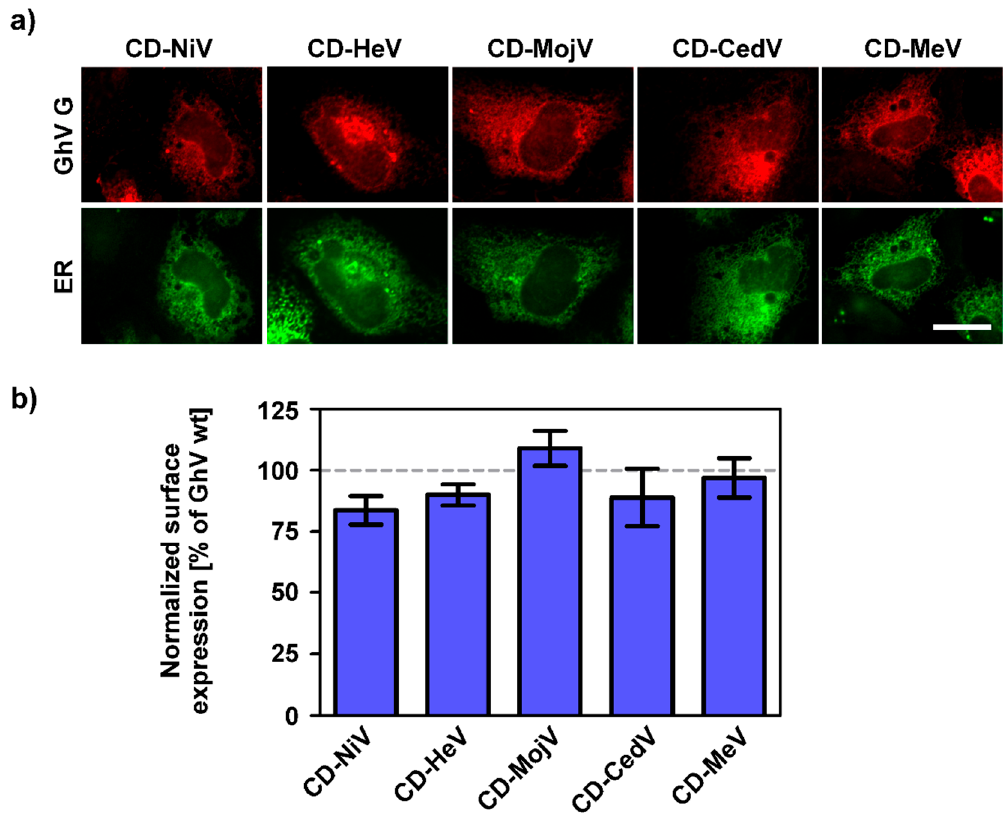
Figure 4. Replacement of the CD of GhV G does not increase the surface expression level. ( a ) Fruit bat (HypNi/1.1) cells were cotransfected for the expression of GhV G proteins harboring the CD of NiV, HeV, MojV, CedV, or MeV and a cellular compartment marker for the endoplasmic reticulum (ER). Red: G proteins, green: ER. Scale bar indicates 20 µm. ( b ) Surface expression of chimeric GhV G proteins was quantified by flow cytometry. The mean fluorescence intensity obtained for the chimeric GhV G proteins was further normalized to wildtype GhV G, which was set as 100%. The graph shows mean and SEM of three independent trials. Statistical significance was tested by paired, two-tailed Student’s t-tests with 95% confidence intervals (no significant differences were obtained: p > 0.05). Table 3. Syncytium formation following coexpression of GhV or NiV F and chimeric G proteins.